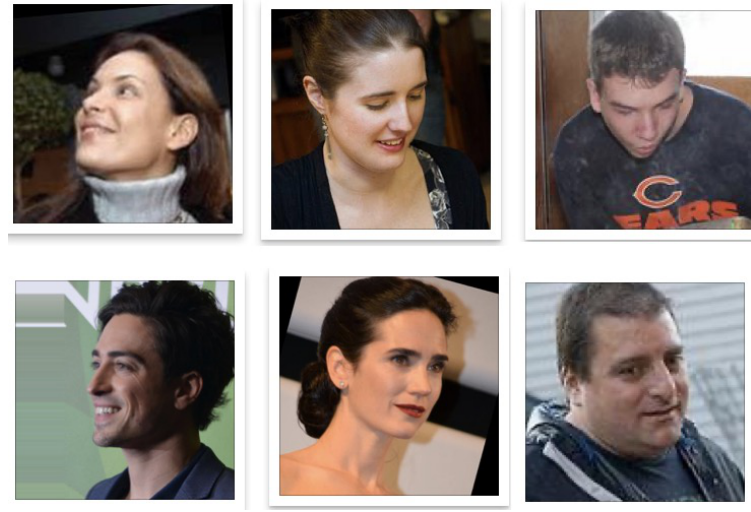
Figure 6. Examples of nonfrontal facial